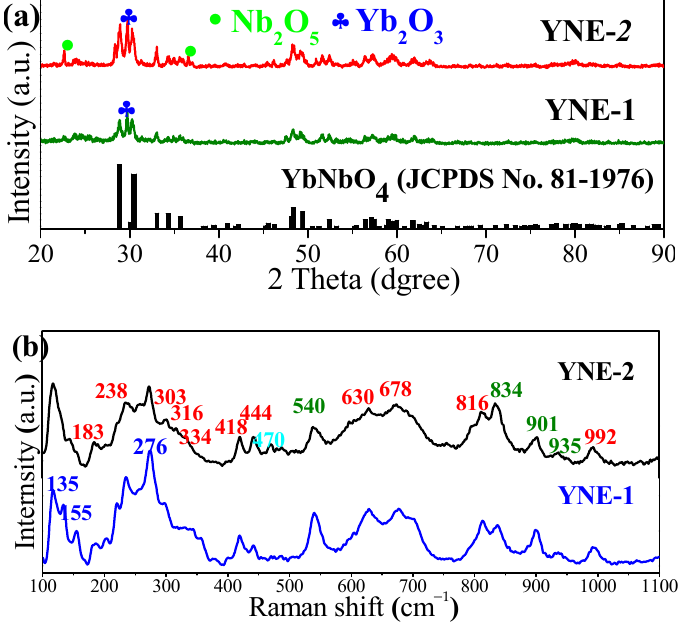
Figure 1. YNE-1 and YNE-2 phosphors; ( a ) XRD patterns; ( b ) Raman